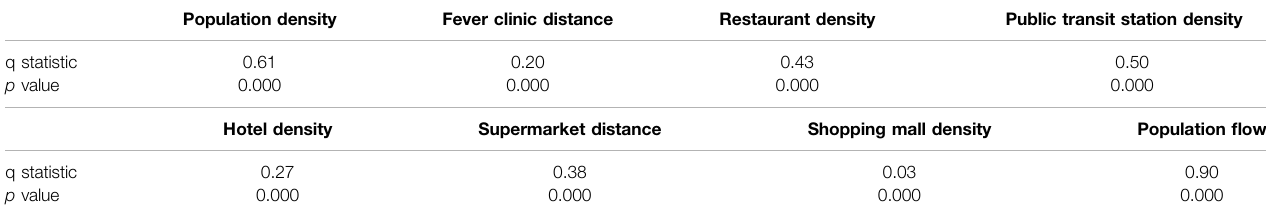
TABLE 2 | Risk factor detector.